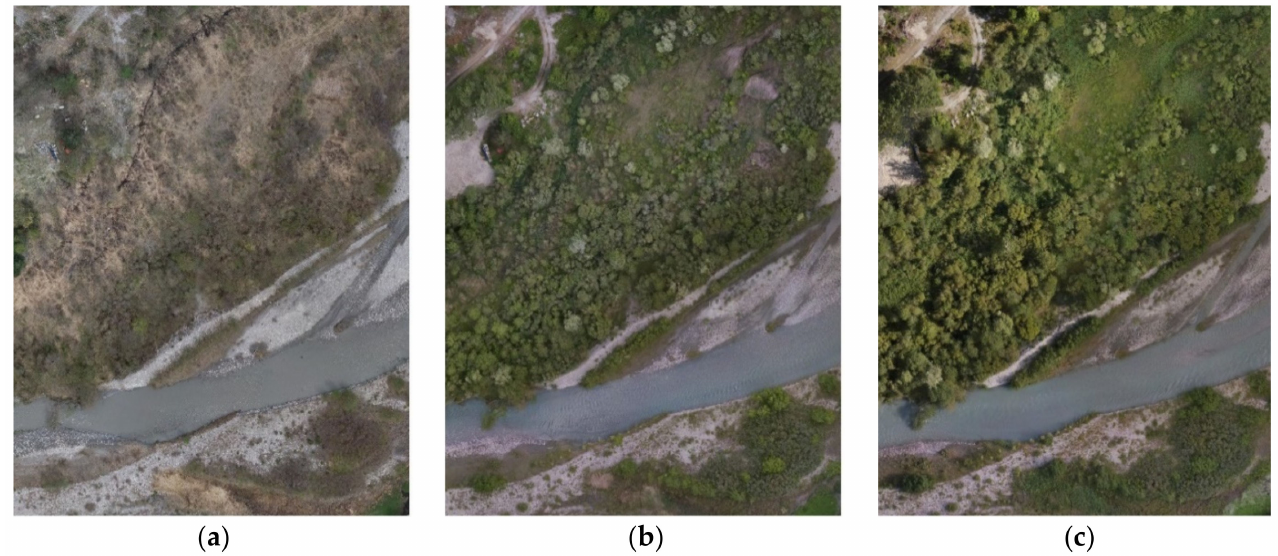
Figure 2. Detail of the orthomosaics of the RGB sensors resulting from the photogrammetric process. ( a ) Epoch I, March; ( b ) Epoch II, June; ( c ) Epoch III, July.